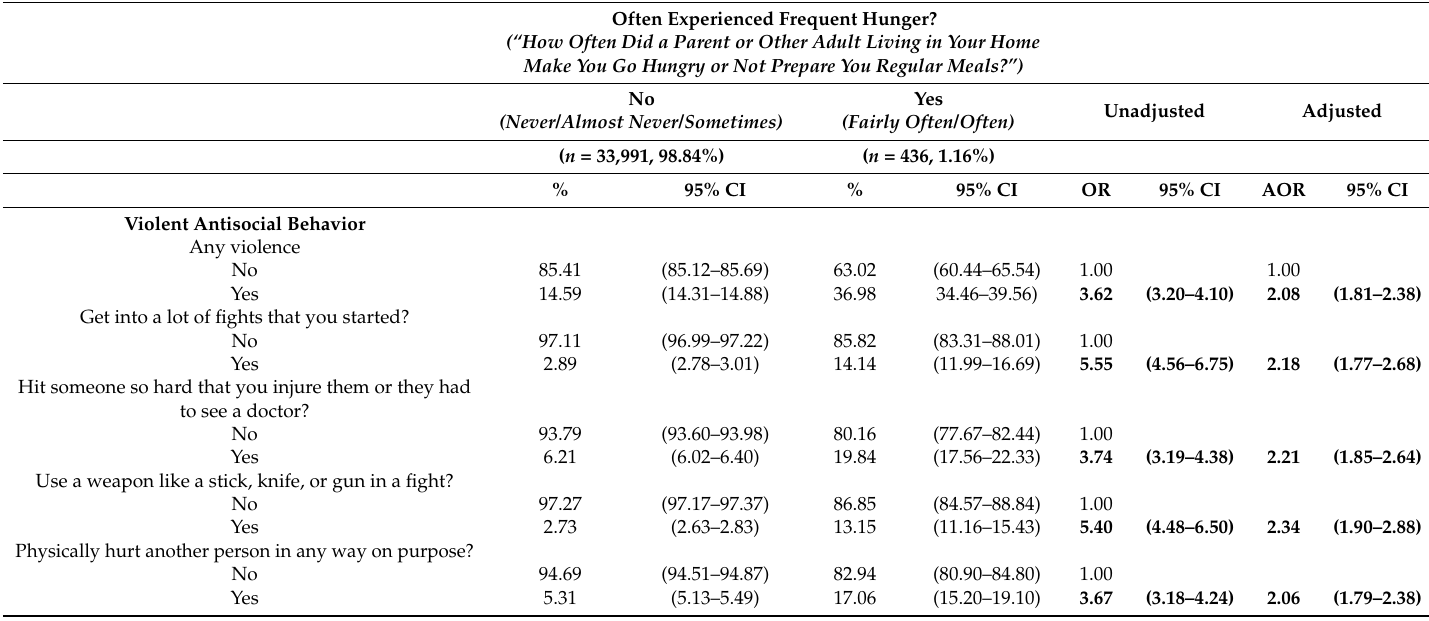
Table 2. Interpersonal violence among individuals who often experienced hunger during childhood in the United States.